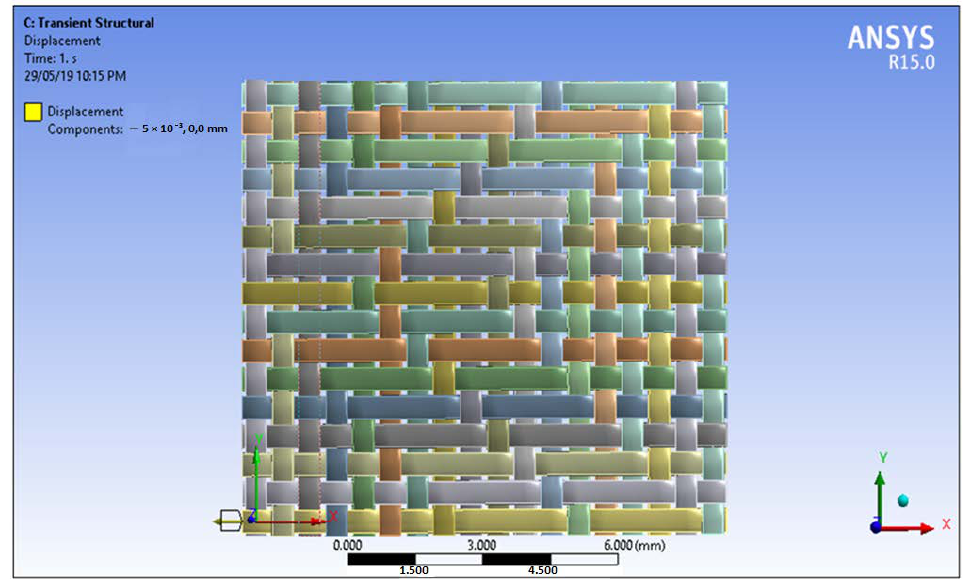
Figure 11. Boundary conditions. Simulation: The left boundary was fixed along the x-direction and a directional dis- placement was applied along the right boundary, with the displacement rate of 2 mm/min. For the tensile test environment simulation, z and y directional displacements were con- strained on both left and right boundaries. For the mechanical analysis of the model, elastic strain in the transverse direction in Figure 12.